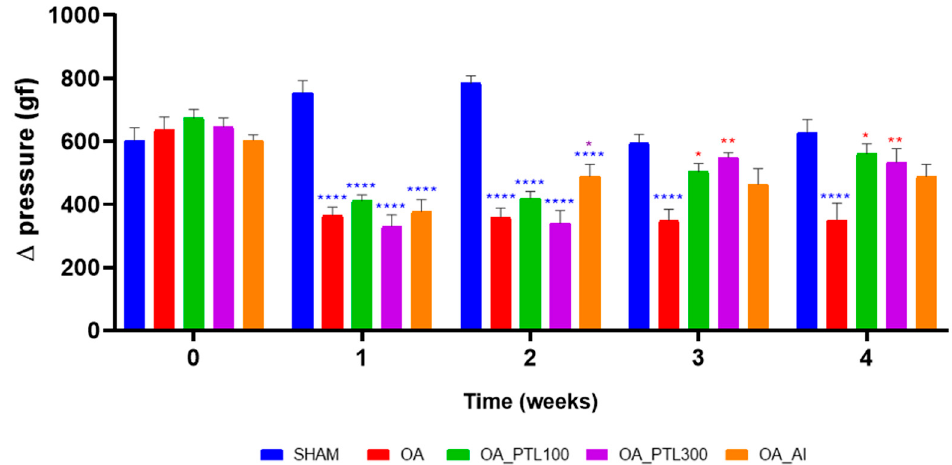
Figure 4. Assessment of mechanical hyperalgesia in the knee throughout the experimental period. Symbols are colored according to their respective experimental group. Differences between the sham, OA, OA_PtL100, OA_PtL300, and OA_AI groups were assessed using a two-way ANOVA. Results